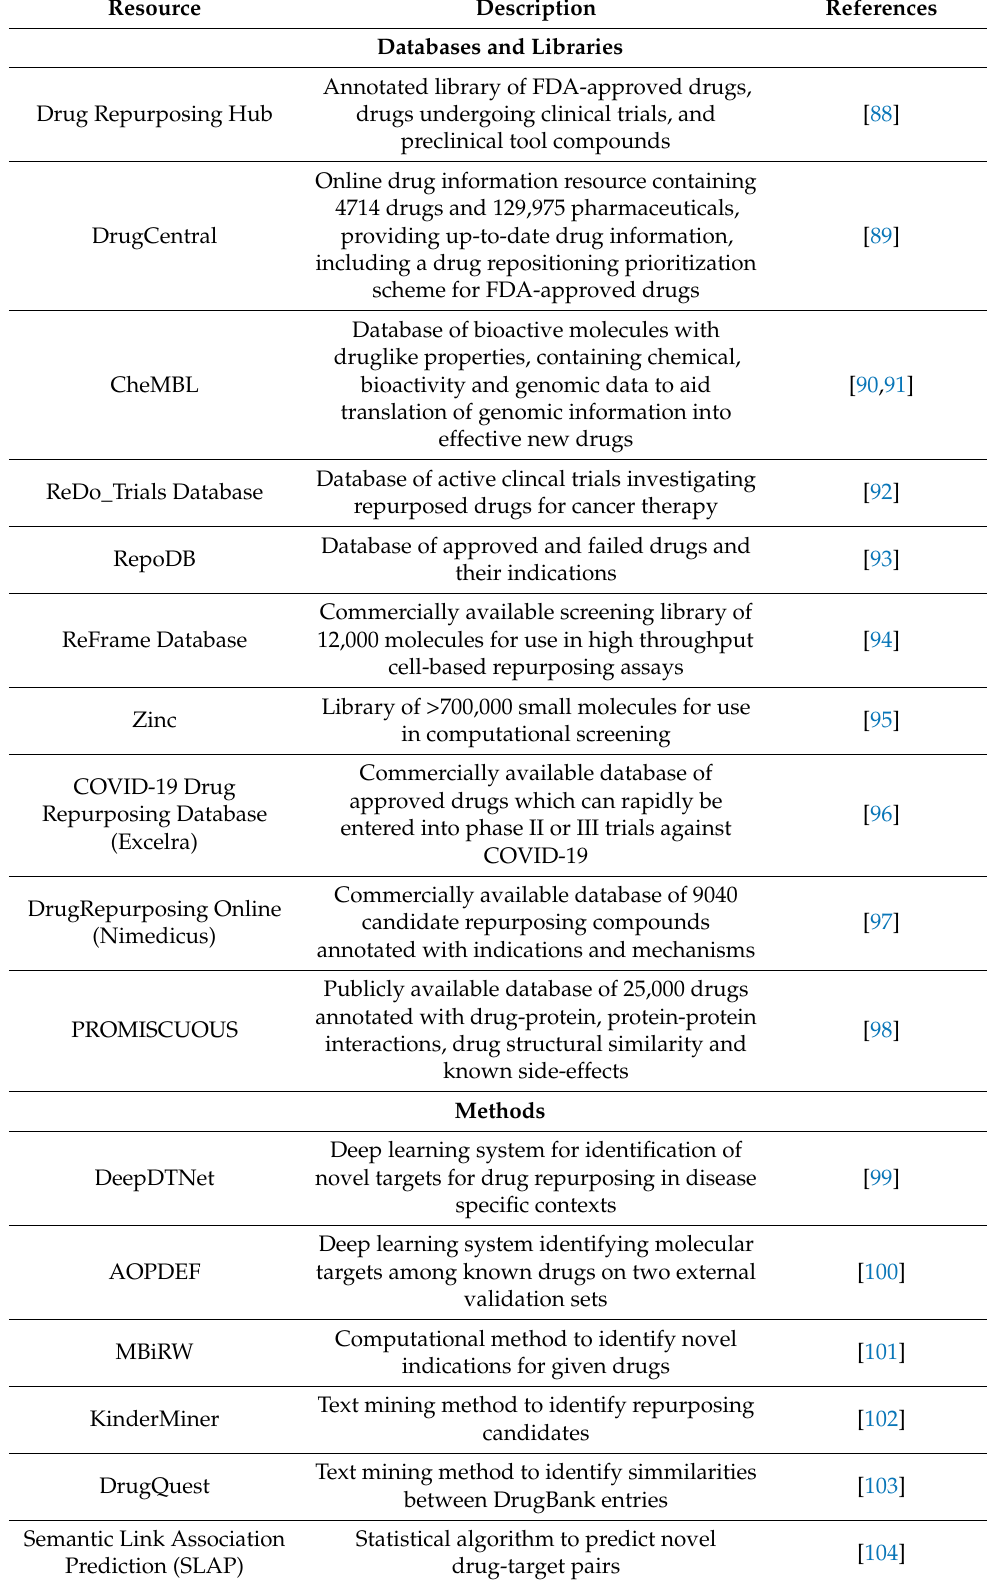
Table 3. List of databases, libraries and methods used in computer-based drug repurposing.